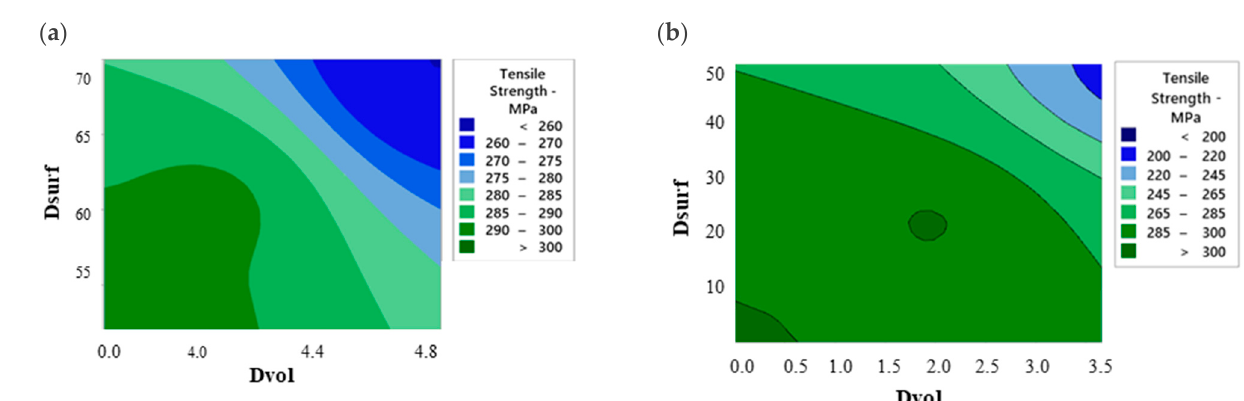
Figure 12. Contour Maps DSurf–DVol–Tensile Strength: ( a ) 1 mm-min and ( b ) 500 mm-min.